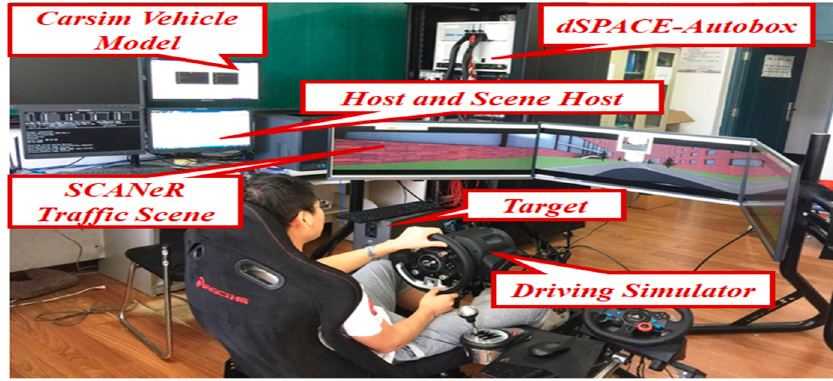
Figure 10 Hardware-in-loop experiment. Figure 10. Hardware-in-loop